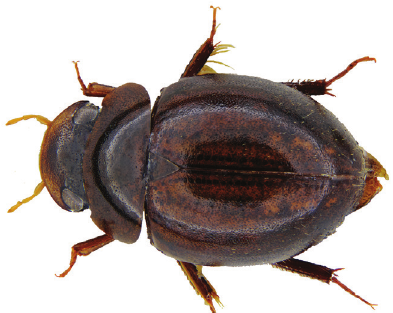
Figure 11. Amphiops senegalensis Laporte, 1840 5.0 mm, iSimangaliso Wetland Park, Eastern Shores (site 14), February 2015 DT Bilton, MS Bird & R Perissinotto leg.